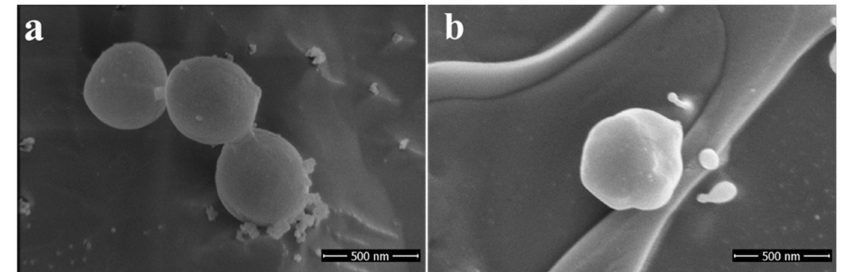
Figure 9. Scanning electron microscope (SEM) image: ( a ) left panel shows untreated coccus cells (VRSA) (CCM 1767), ( b ) right panel shows treated coccus (VRSA) (CCM